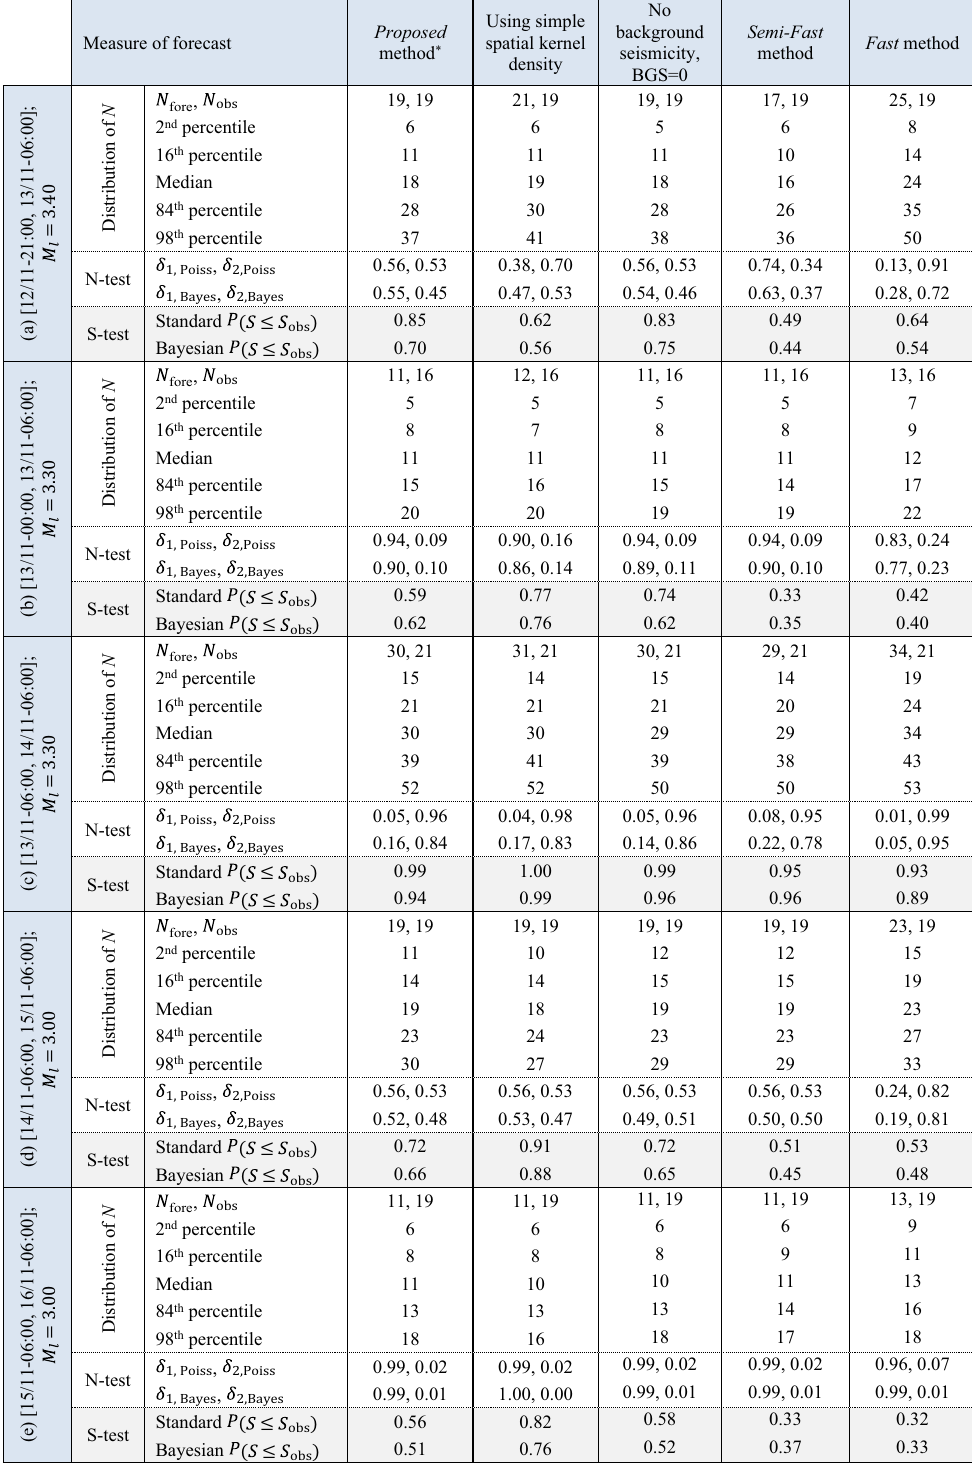
Table 2. N-test and S-test results in different forecasting intervals considering different